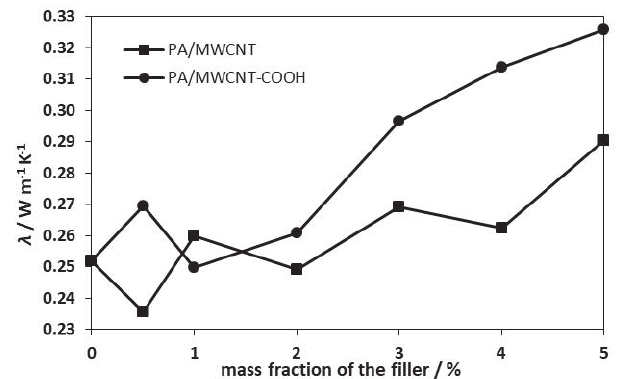
Fig. 9 – Influence of mass fraction of filler on thermal con- ductivity for PA/MWCNT and PA/MWCNT-COOH nanocom- posites